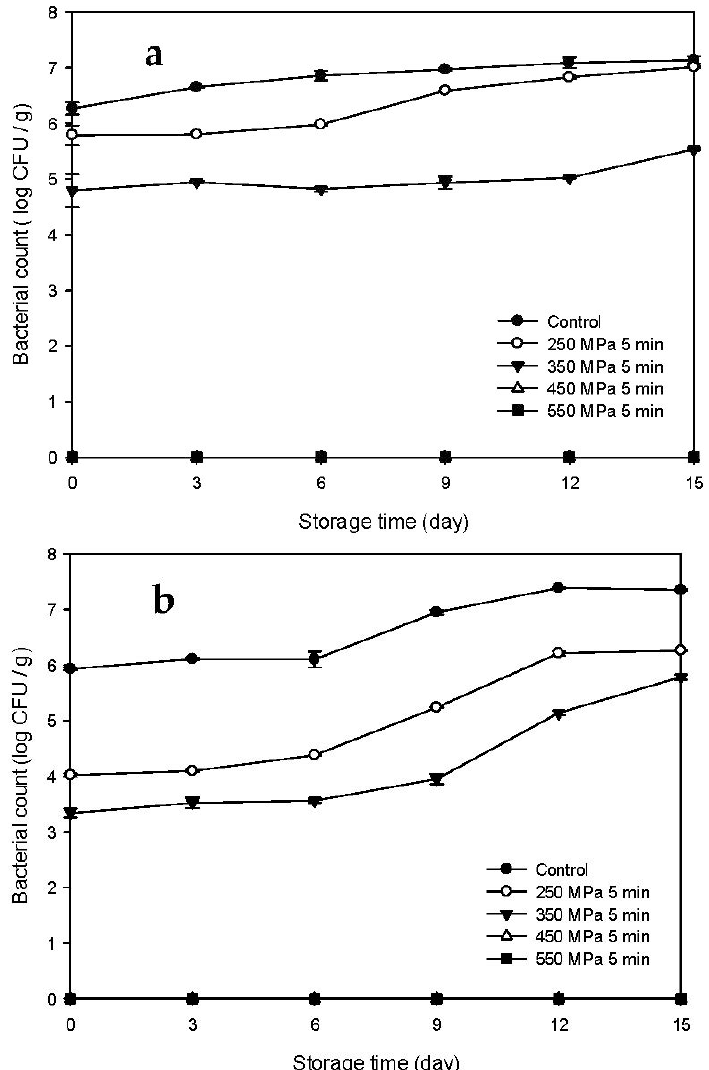
Figure 2. Changes in bacterial counts of tuna meat samples inoculated with ( a ) Morganella morganii and ( b ) Photobacterium phosphoreum after high-pressure processing treatment at 250, 350, 450, and 550 MPa for 5 min during storage at 4 °C.